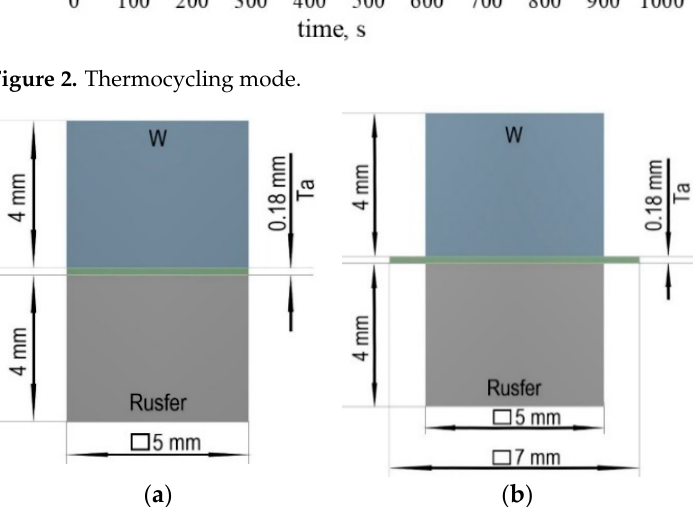
Figure 2. Thermocycling mode.